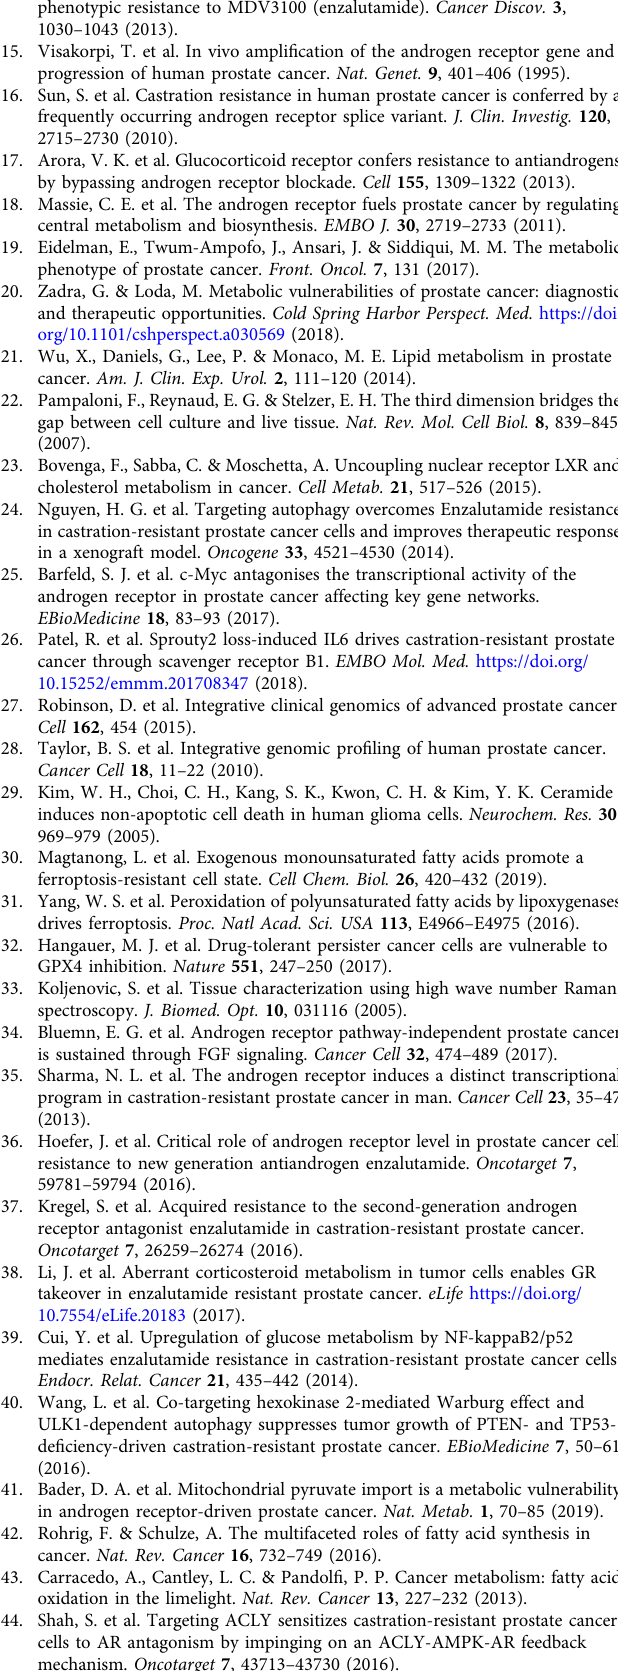
Figure 2: Panel b: n = 3 independent biological experiments; Panels c, d, e: n = 3 independent wells from the same cell culture. Figure 3: Panel a: n = 3 independent wells from the same cell culture. Panel b: representative image from three independent biological experiments. Panel c: n = 3 independent biological experiments. Figure 4: Panel a: n = 3 independent wells from the same cell culture. Panel b: representative image from three independent biological experiments. Figure 5: Panels b, c, f: representative image from three independent biological experiments. Panel d: n = 9 (three independent biological experiments performed in triplicates). Panel e: n = 6 (three independent biological experiments performed in duplicates). Panel g: n = 14. Figure 6: Panels a, g, h: representative image from three independent biological experiments. Panels b, i, j: n = 6 (three independent biological experiments performed in duplicates). Panels c, d: n = 3 independent biological experiments. Panels e, f: n = 3 independent wells from the same cell culture. Figure 7: Panel a: n = 6 mice per group. Panel b: n = 5 mice per group. Panel c: n = 7203 (CTL), 5425 (KO) peak intensities that were extracted from four mice per group. Panel d: n = 3 mice per